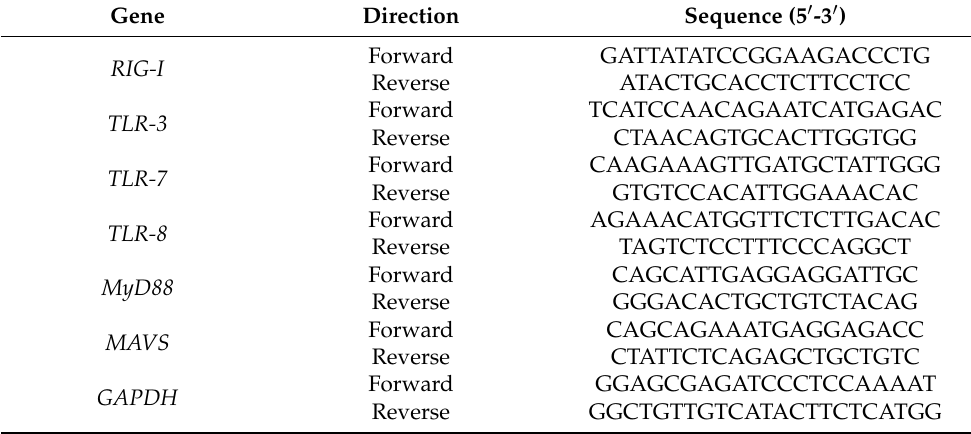
Table 1. Primer sequences of qPCR.